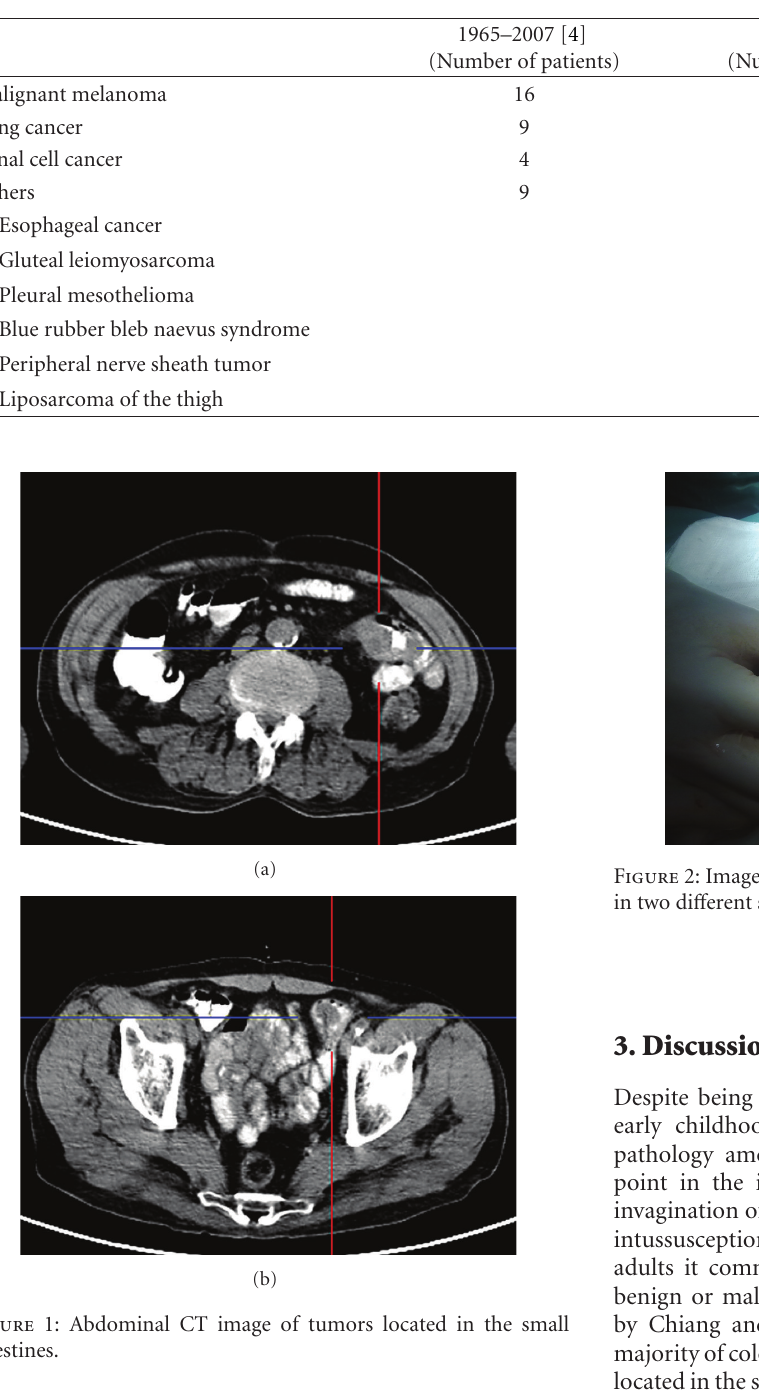
Table 1: Reported cases of adult small bowel intussusception caused by metastatic disease.